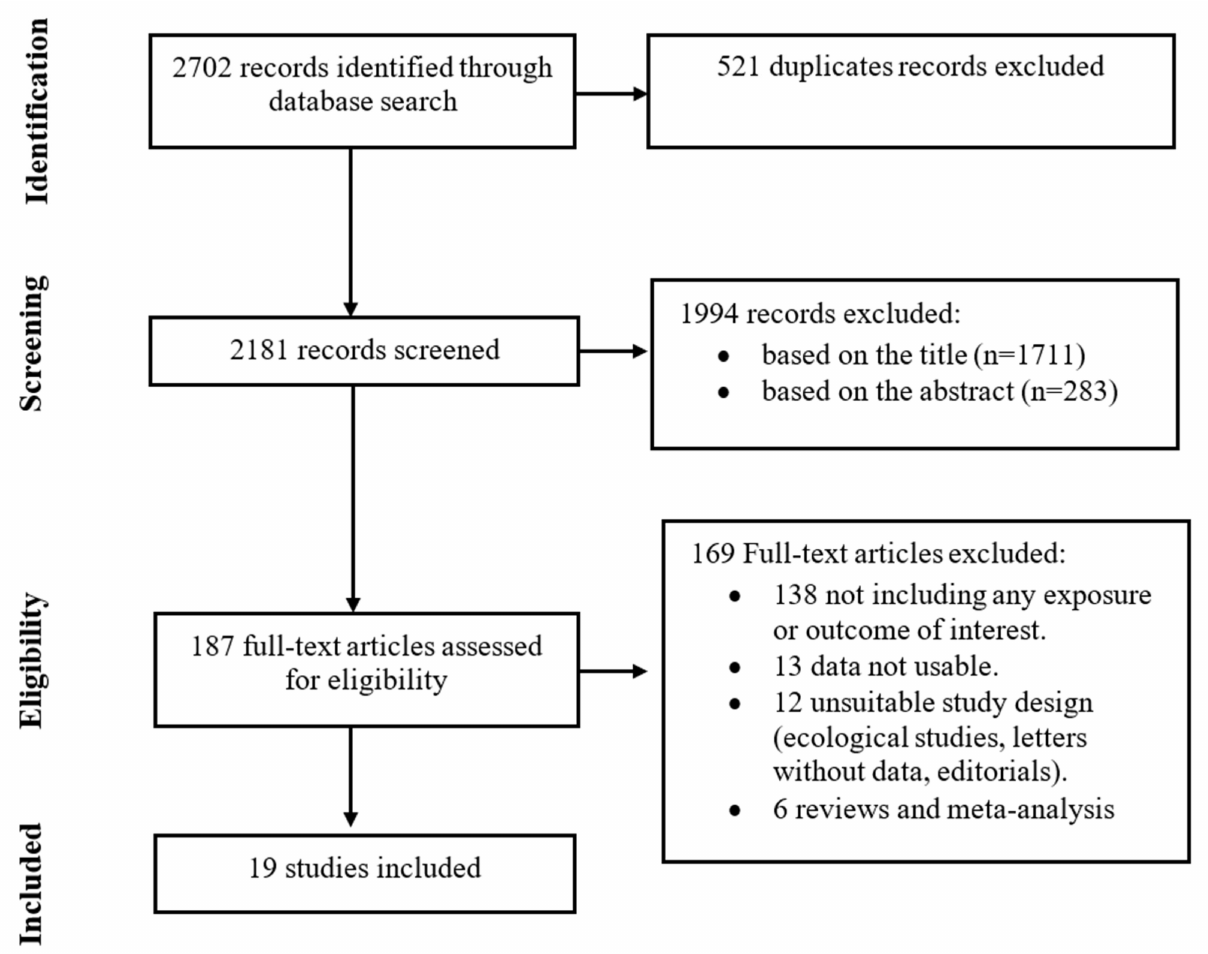
Figure 1. Flow-chart depicting the literature search and article selection for the systematic review of papers focusing on the association between alcohol intake and fatal prostate cancer risk, prostate cancer mortality, and survival (or surrogates thereof) of prostate cancer